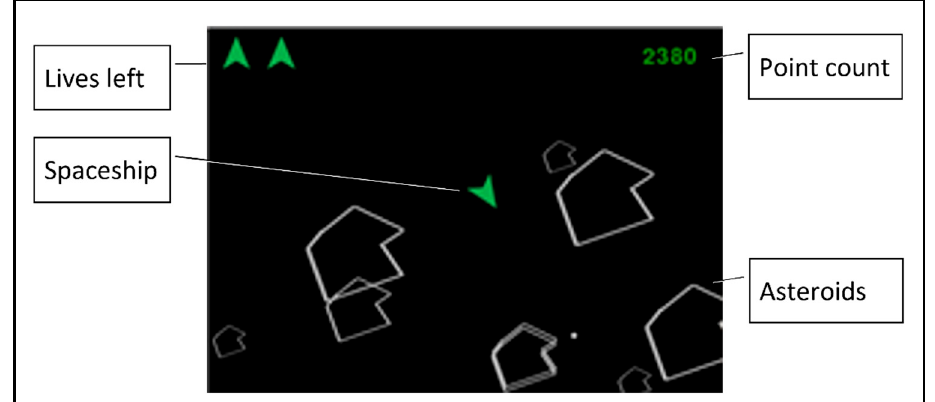
Figure 2. “Asteroids” computer game: typical display.